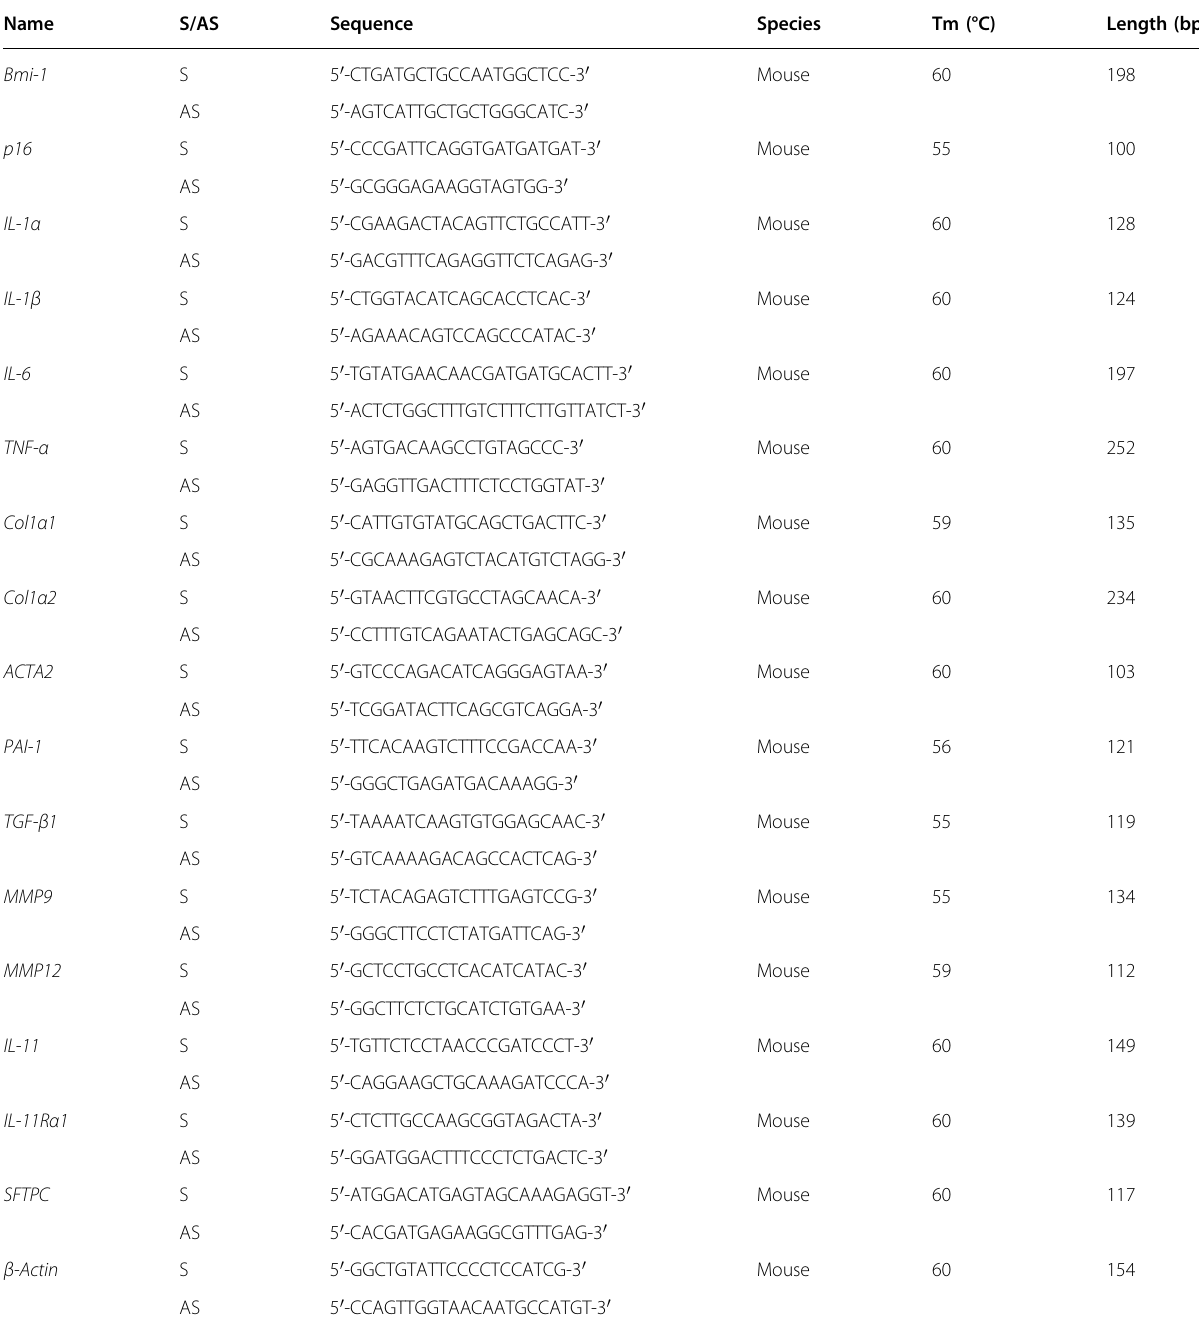
Table 1 Primer for real-time